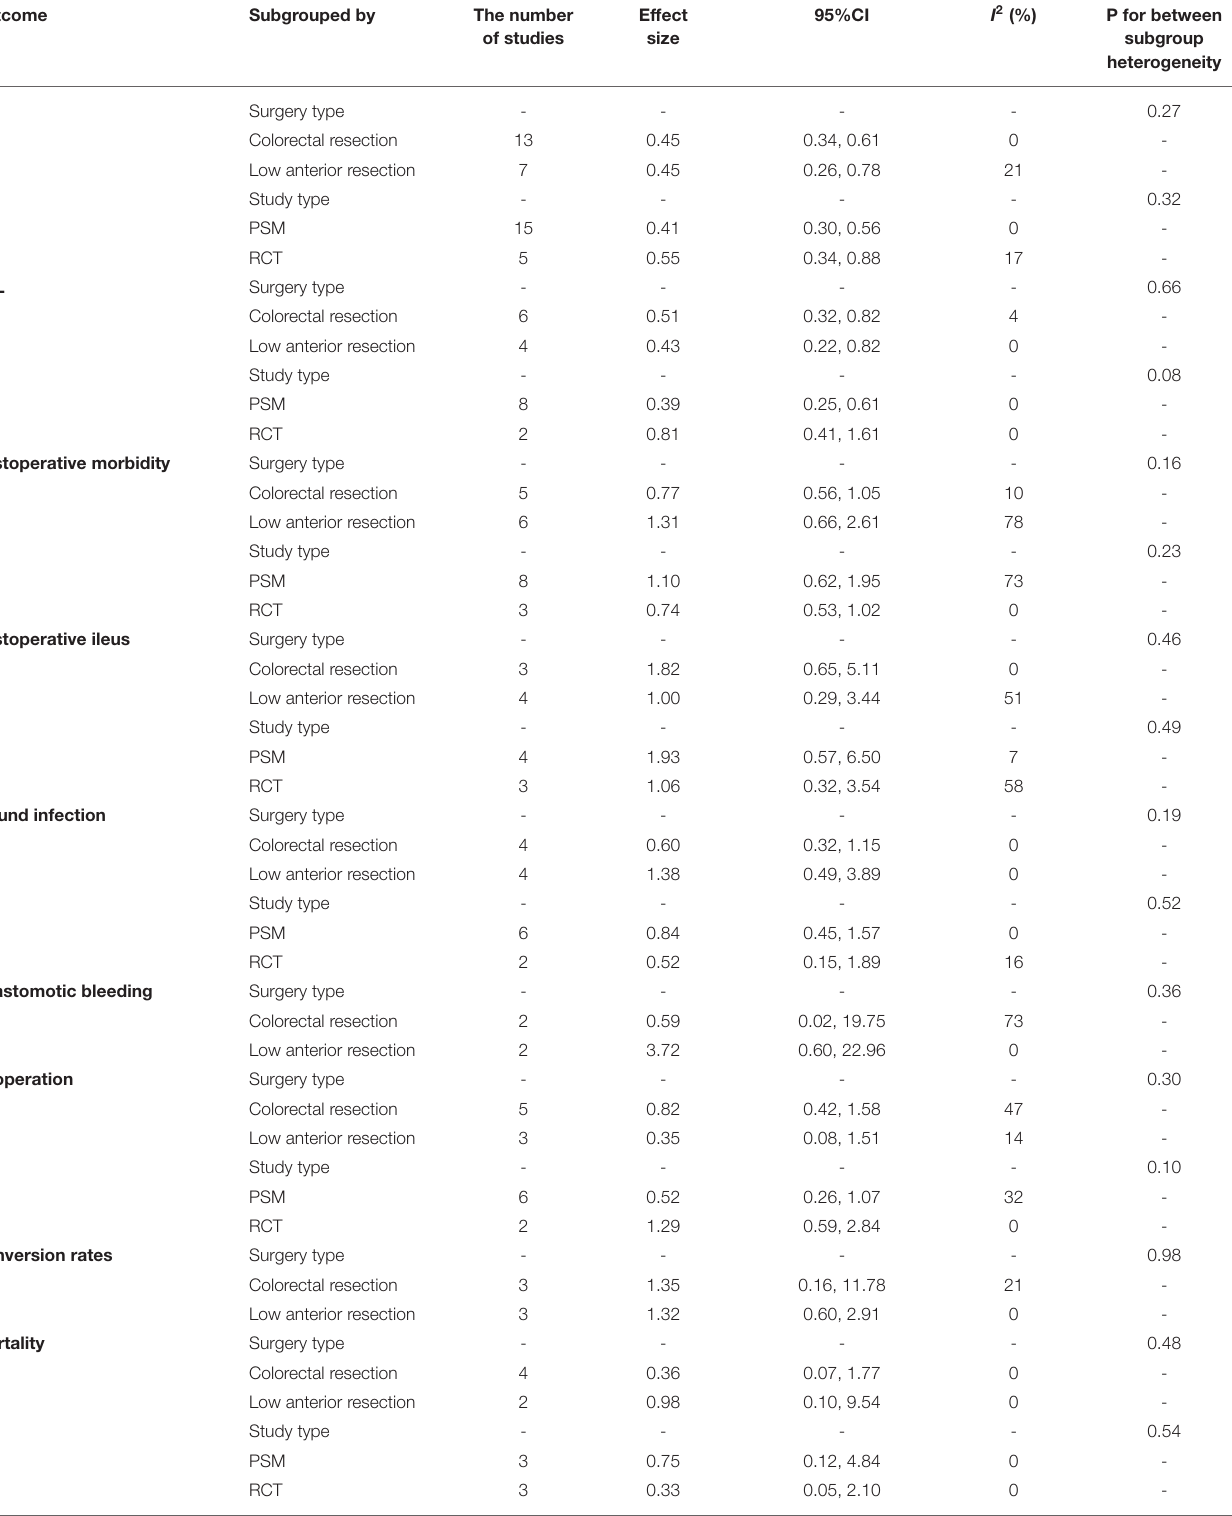
TABLE 3 | Summary of results from all subgroup analyses.